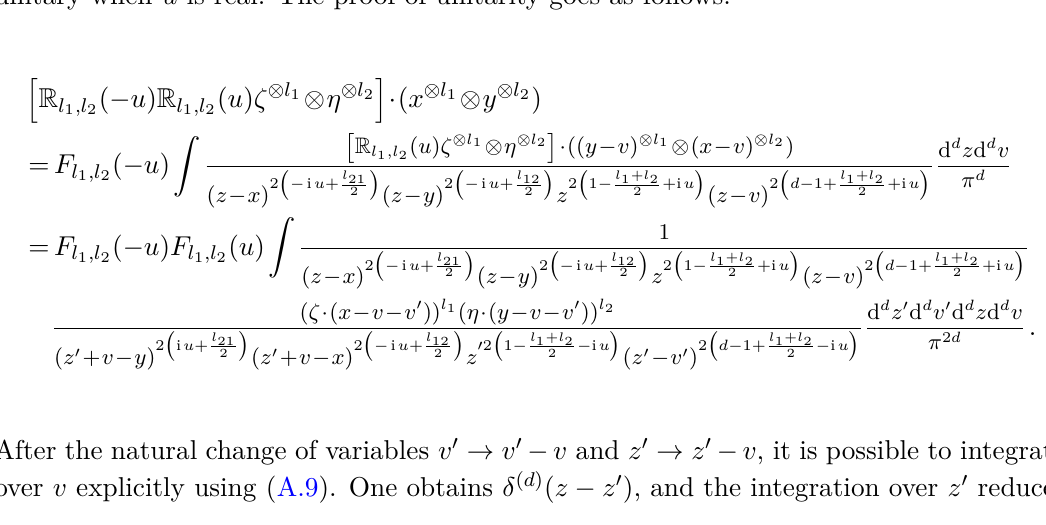
( u ) introduced in figure 2. 1 l 2